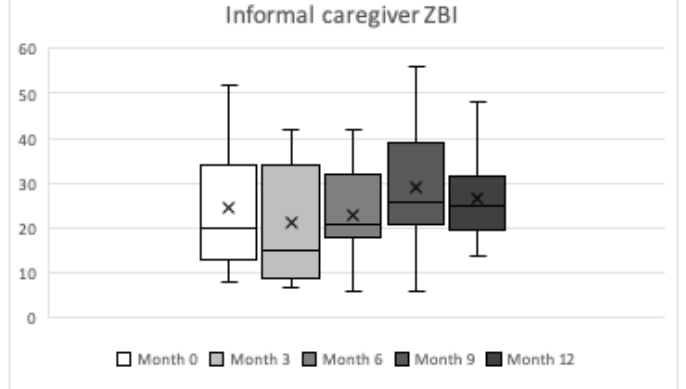
Figure 8. Informal caregivers’Zarit Burden Interview year progression (minimum, quartile 1, median, quartile 3,